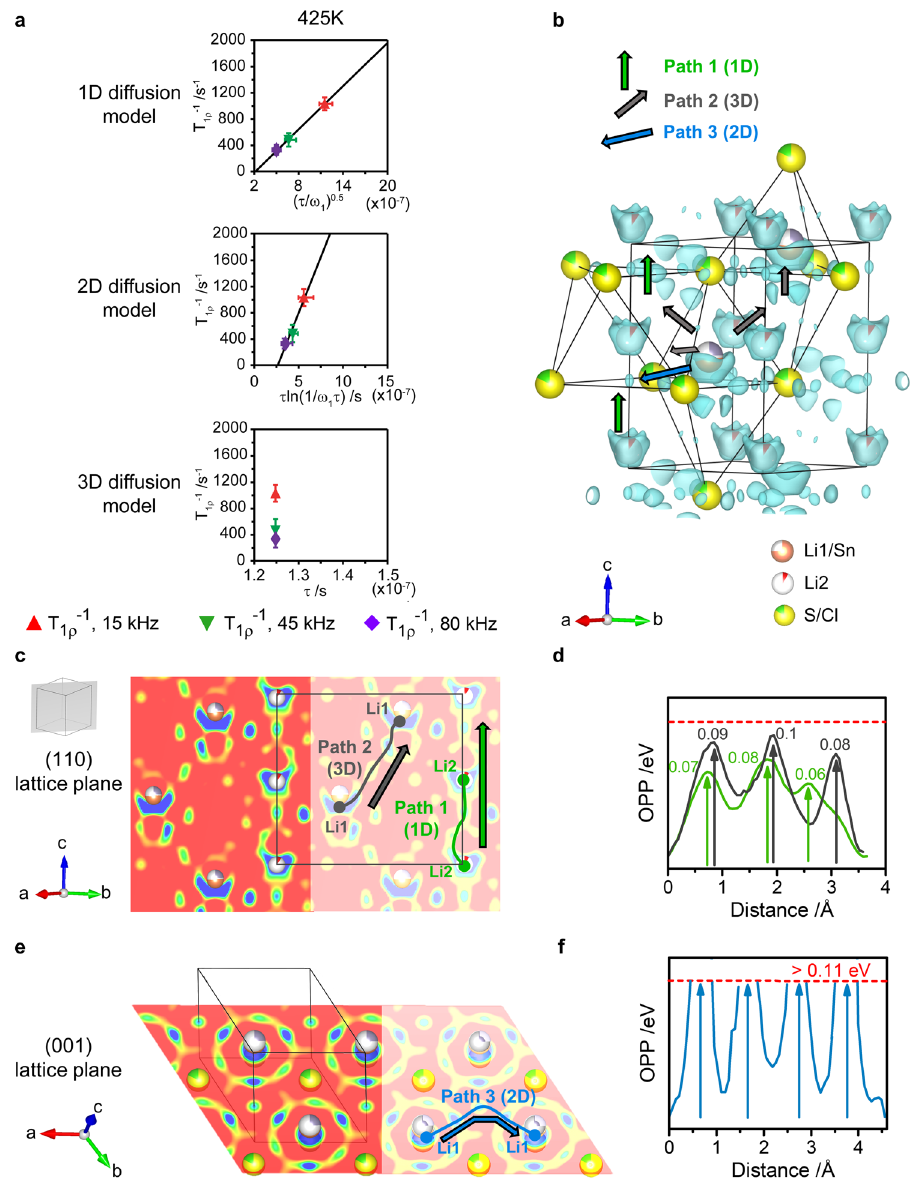
Fig. 5 Li diffusion pathways in Li 3.3 SnS 3.3 Cl 0.7 . a Frequency dependence of the NMR SLR T 1 ρ − 1 rates at 425 K for one-dimensional, two-dimensional and three-dimensional diffusion models, as a function of spin-lock frequencies ω 1 /2 π of 15 (red triangle), 45 (green inverted triangle), 80 kHz (purple diamond) and average Li + jump times τ from T 1 ρ − 1 maxima (Fig. 4c). The black lines correspond to linear fi ts with regression factor r 2 of 0.99 for 1D and 0.98 for 2D diffusion. Data for other temperatures are given in Supplementary Fig. 17. Errors in the spin-lock frequencies ω 1 are estimated to be 10% while the errors in the correlation time τ are extracted from the fi t in Supplementary Fig. 16. Errors in T 1 ρ − 1 are obtained from the outputs of the fi ts to Supplementary Equation 3. b Nuclear density reconstructed by the maximum entropy method and highlighted potential diffusion pathways (Path 1 (1D): green arrow, Path 2 (3D): gray arrows and Path 3 (2D): blue arrows). c Nuclear density in the (110) lattice plane and d estimated one particle potential (OPP) along the two diffusion pathways in this plane (Path 1: green line; Path 2: gray line), energy barriers are indicated on the plot in eV. e Nuclear density in the (001) lattice plane and f OPP estimated along Path 3 in this plane. The dashed red line on d and f corresponds to the maximum OPP that can be calculated given the background level of the nuclear density. Density levels on b , c , e are plotted in the [-0.02 fm Å − 3 ; 0 fm Å − 3 ] range to identify scattering from